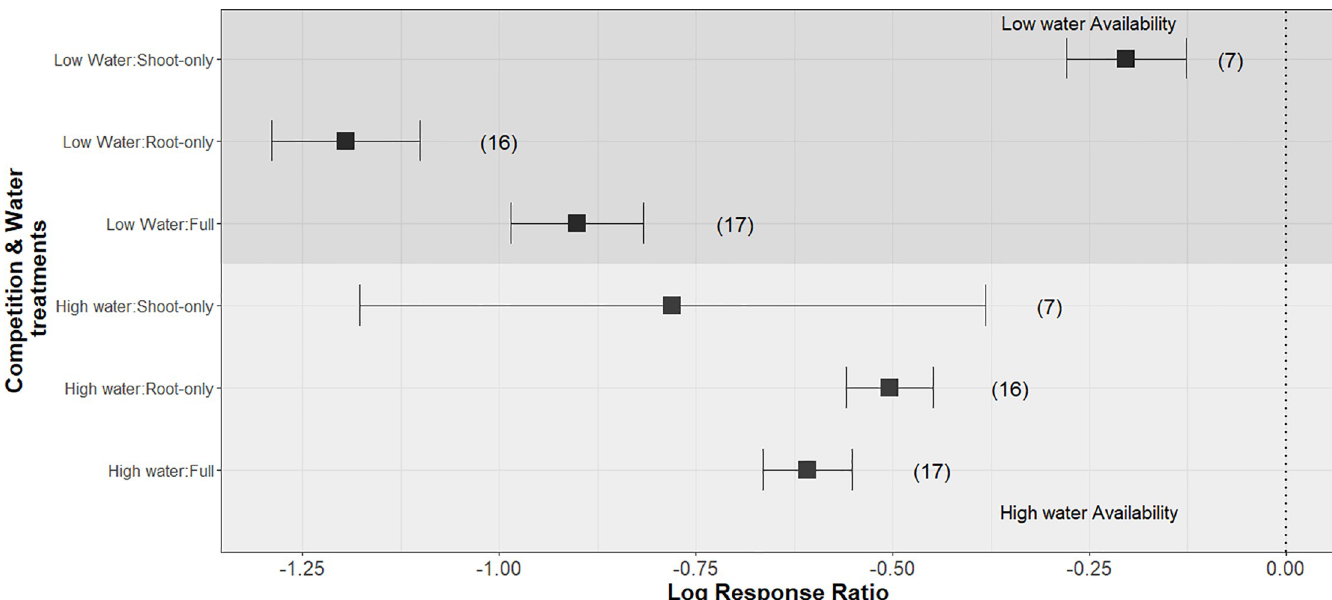
Fig 4. Effects of water availability and competition on plant growth. Meta-estimates (square points) and 95% confidence intervals. Smaller values indicate intense competition, while larger values indicate weaker competition. Sample sizes of lnRR values are in parentheses.